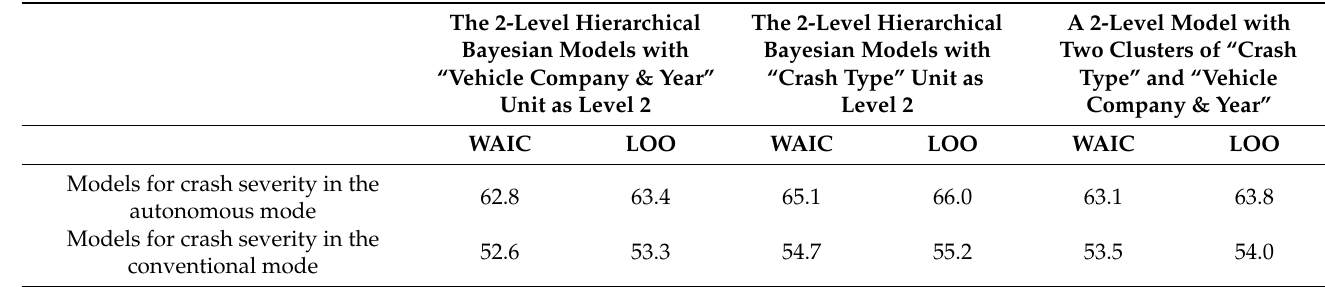
Table 6. WAIC and LOO of hierarchical Bayesian models with different observation